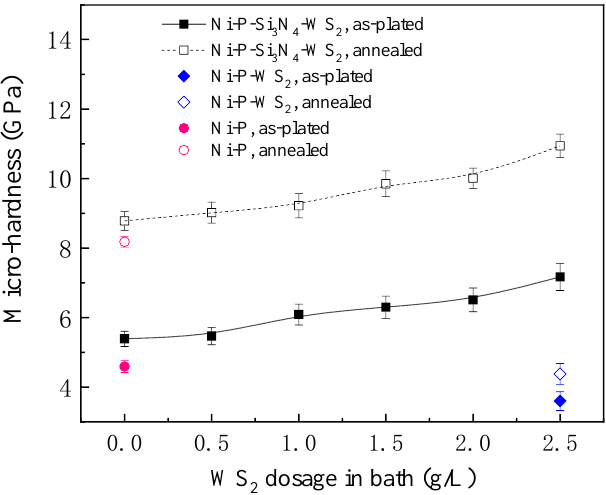
Figure 4. Dependence of the hardness of Ni-based coatings with WS 2 dosage in bath.